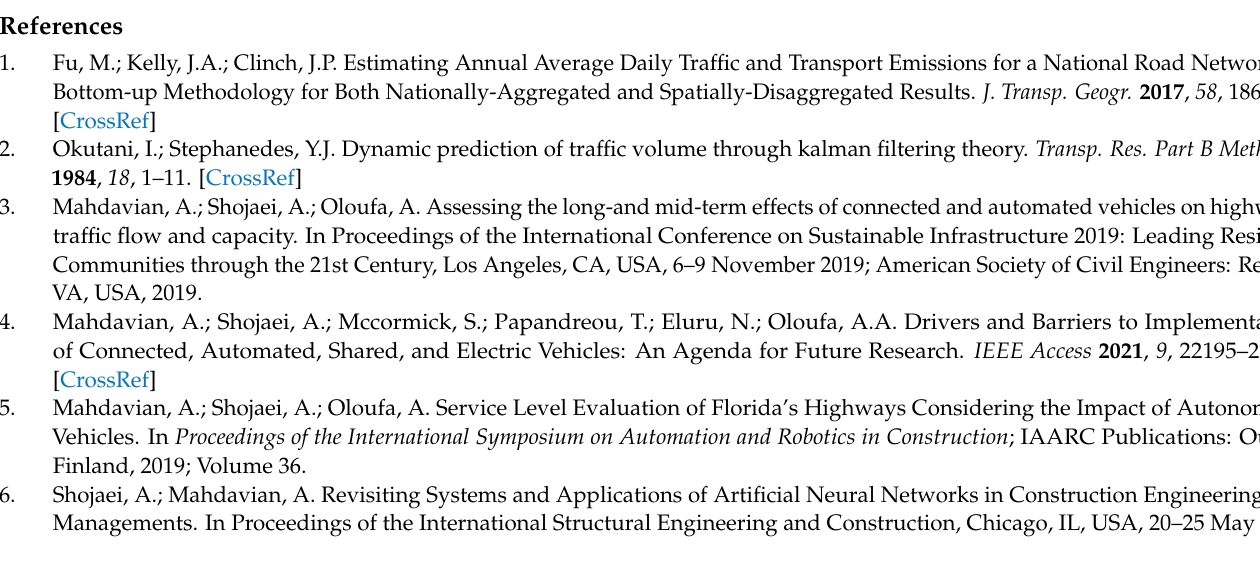
Figure A2. Independent variables employed in this research.